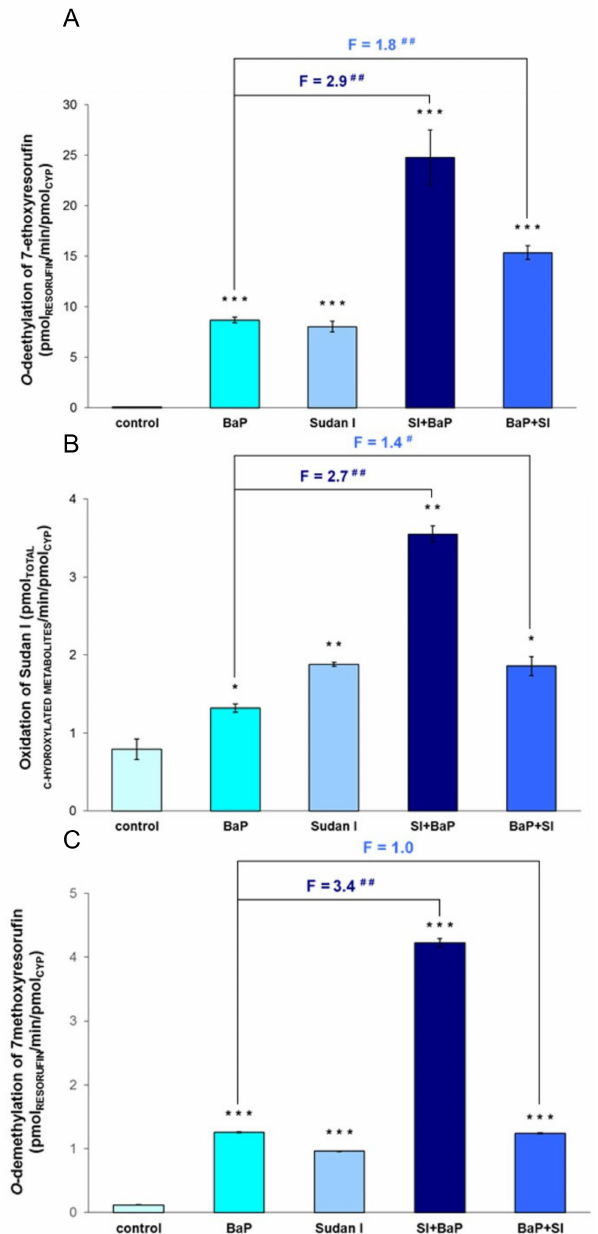
Figure 6. CYP1A1 and 1A2 enzyme activities measured by marker reactions of 7-ethoxyresorufin O -deethylation for CYP1A1 ( A ), Sudan I oxidation for CYP1A1 ( B ) and 7-methoxyresorufin O -demethylation for CYP1A2 ( C ) in hepatic microsomes isolated from control (untreated) rats and rats exposed to BaP alone, Sudan I alone, Sudan I before BaP treatment (SI + BaP) or Sudan I after BaP treatment (BaP + SI). All values are given as the means ± S.D. of three parallel measurements. Numbers above columns (“F”) indicate fold changes in enzyme activities in comparison to ani- mals treated with BaP alone. Statistical comparison was performed by t -test analysis: # p < 0.05, ## p < 0.01—results significantly different from rats treated with BaP alone; * p < 0.05, ** p < 0.01, *** p < 0.001—significantly different from control (untreated)